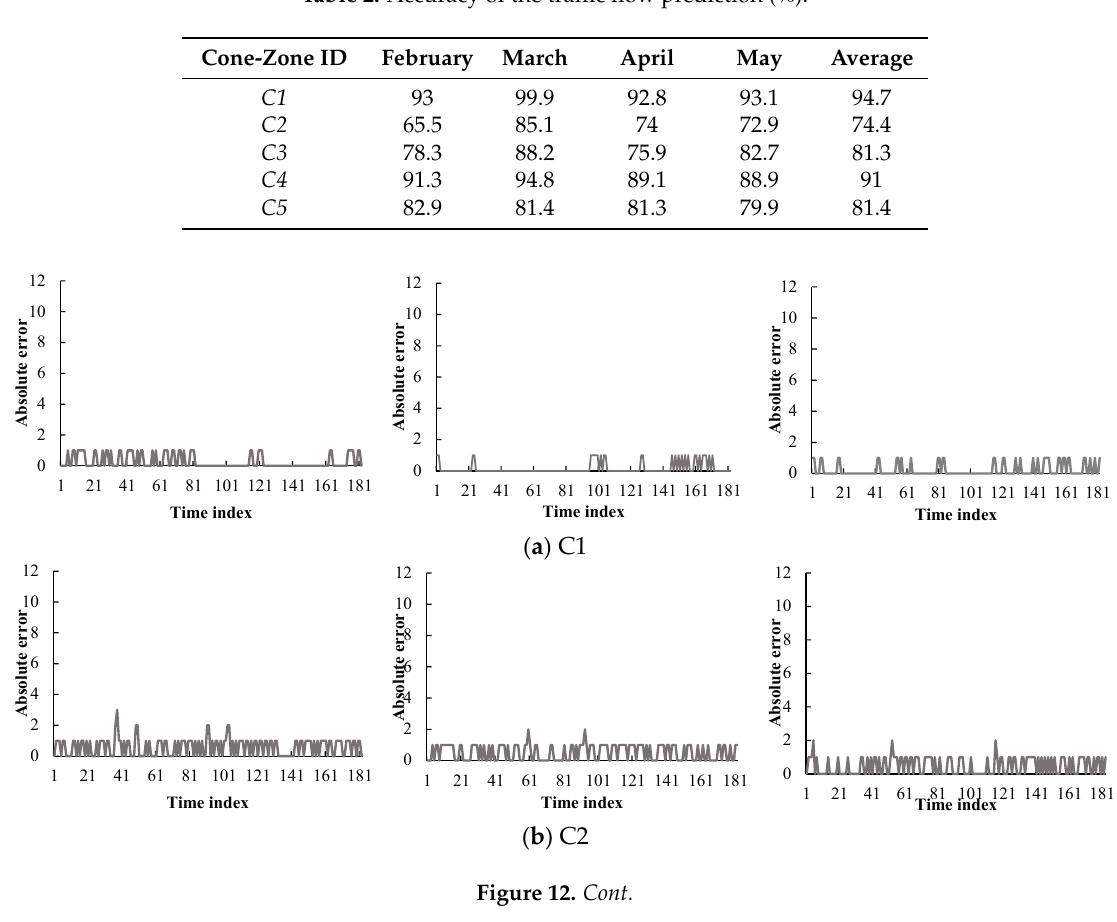
Table 2. Accuracy of the traffic flow prediction (%).